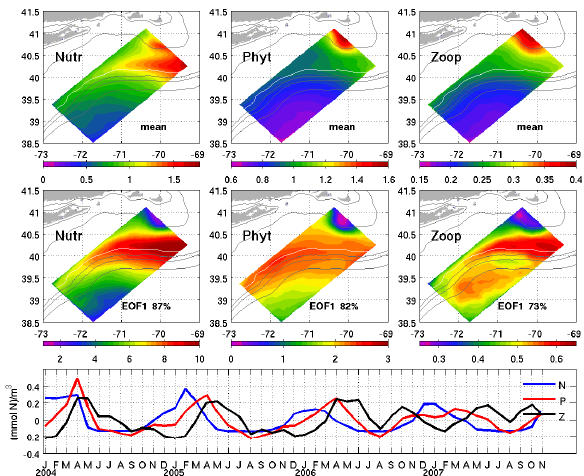
Figure 8. EOF analyses of upper water column (averaged over the upper 50 m) 865 Fig. 8. EOF analyses of upper water column (averaged over the nutrient, phytoplankton and zooplankton fields. Mean fields are shown in the top 866 upper 50m) nutrient, phytoplankton and zooplankton fields. Mean panels (units: (mmol N)/m 3 ), the first EOF modes with the variance they account for 867 fields are shown in the top panels (units: (mmolN)m − 3 ) , the first are shown in the middle panels and their corresponding 1 st principle components are 868 shown in the bottom panels. Also shown are isobaths (gray curves) with 200 m 869 EOF modes with the variance they account for are shown in the isobath highlighted in white. 870 middle panels and their corresponding 1st principle components are 871 shown in the bottom panels. Also shown are isobaths (gray curves) with 200m isobath highlighted in